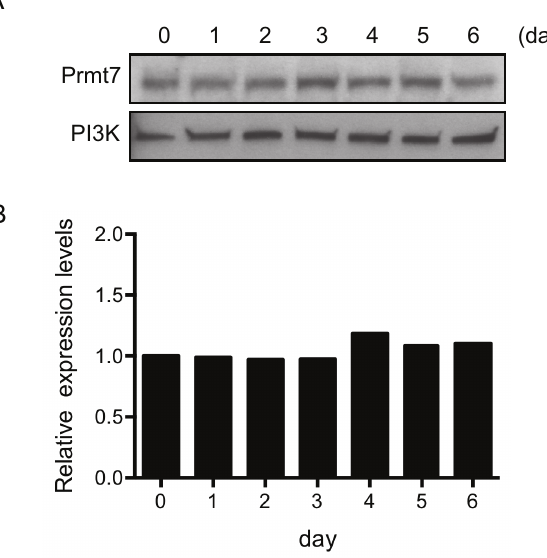
Figure 1. Prmt7 protein levels are constant in differentiating C3H10T1/2 cells. ( A ) Western blot analysis of the protein extracts